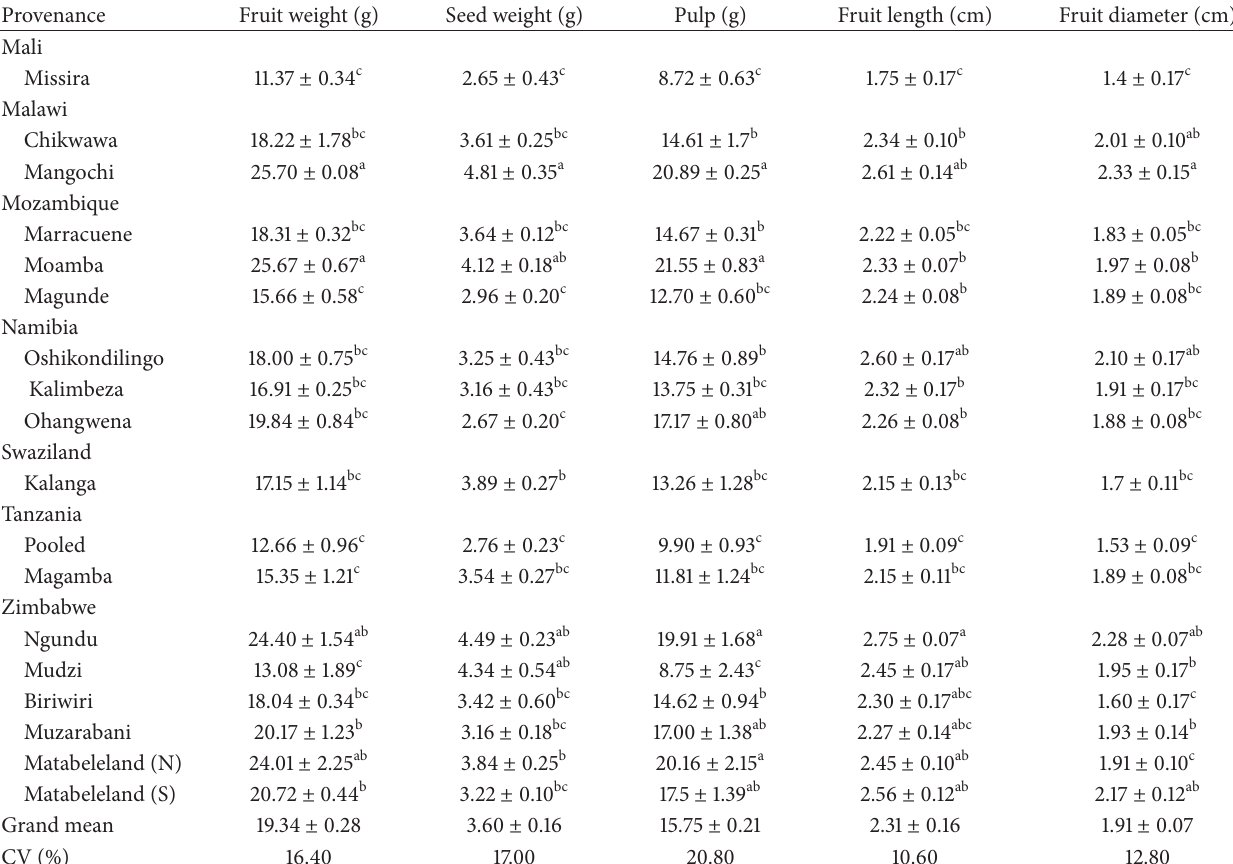
Table 3: Variation in fruit traits characteristics among fruiting provenances in